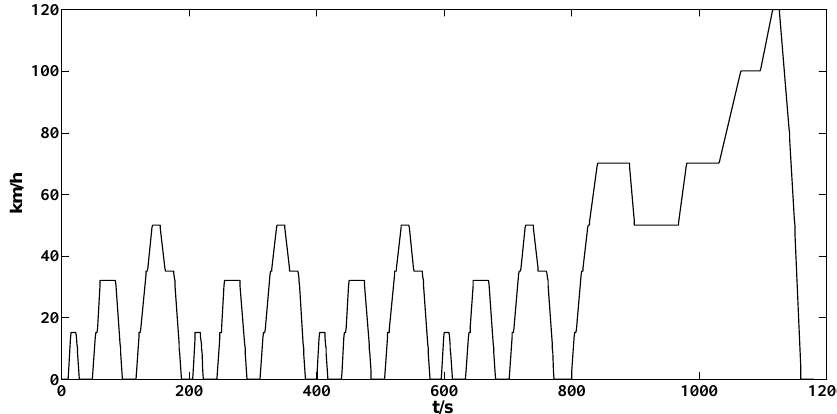
Figure 6. Driving cycle of New European Driving Cycle (NEDC).